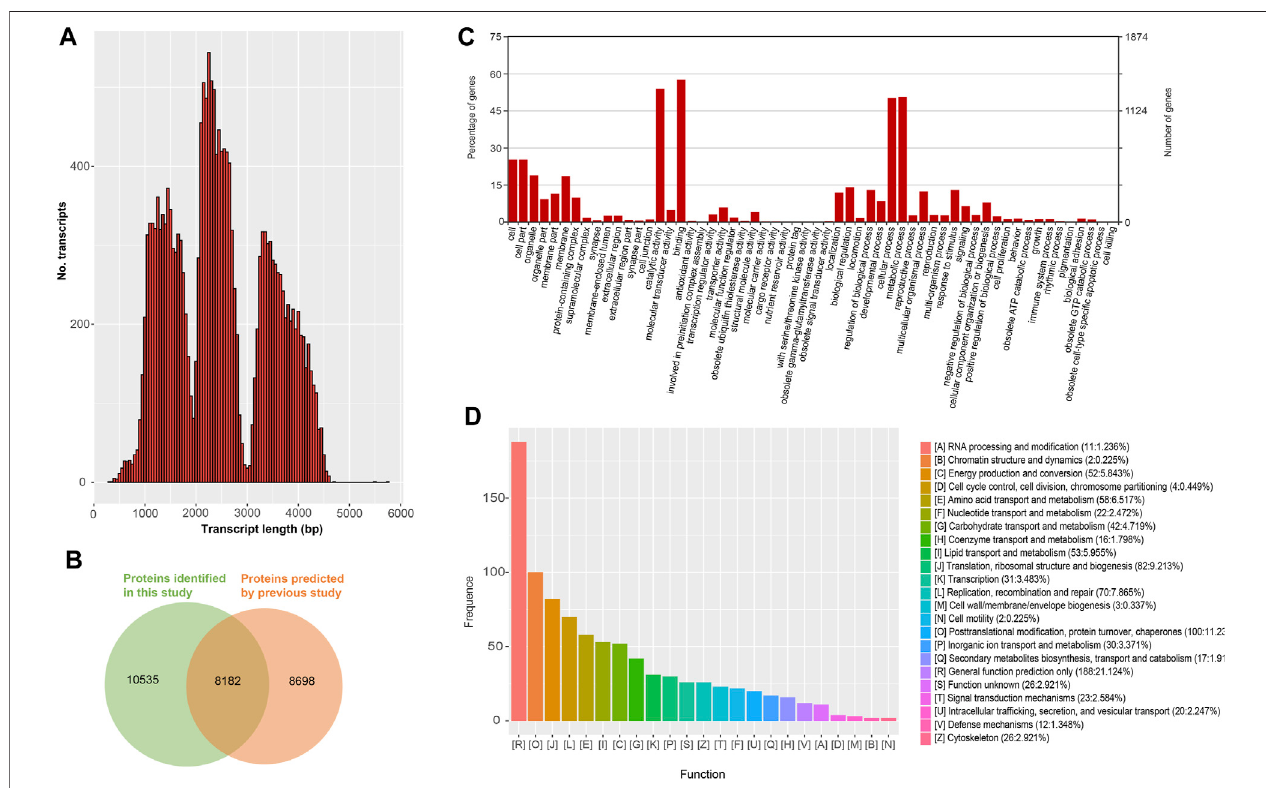
FIGURE3| Proteincodingtranscripts (A) Thedistributionofallprotein codingtranscriptslength( B ) Venndiagram oftheproteincodingtranscripts identi fi edinthis study and previously reported protein coding transcripts ( C ) Gene Ontology (GO) terms distribution of all protein coding transcripts ( D ) Clusters of Orthologous Groups (COGs) of all protein coding